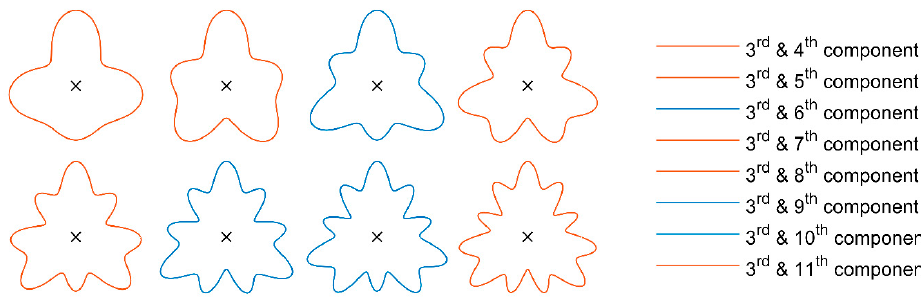
Figure 9. Profiles in which the third component is paired with components 4–11. The red profiles produce BSV and the blue profiles do